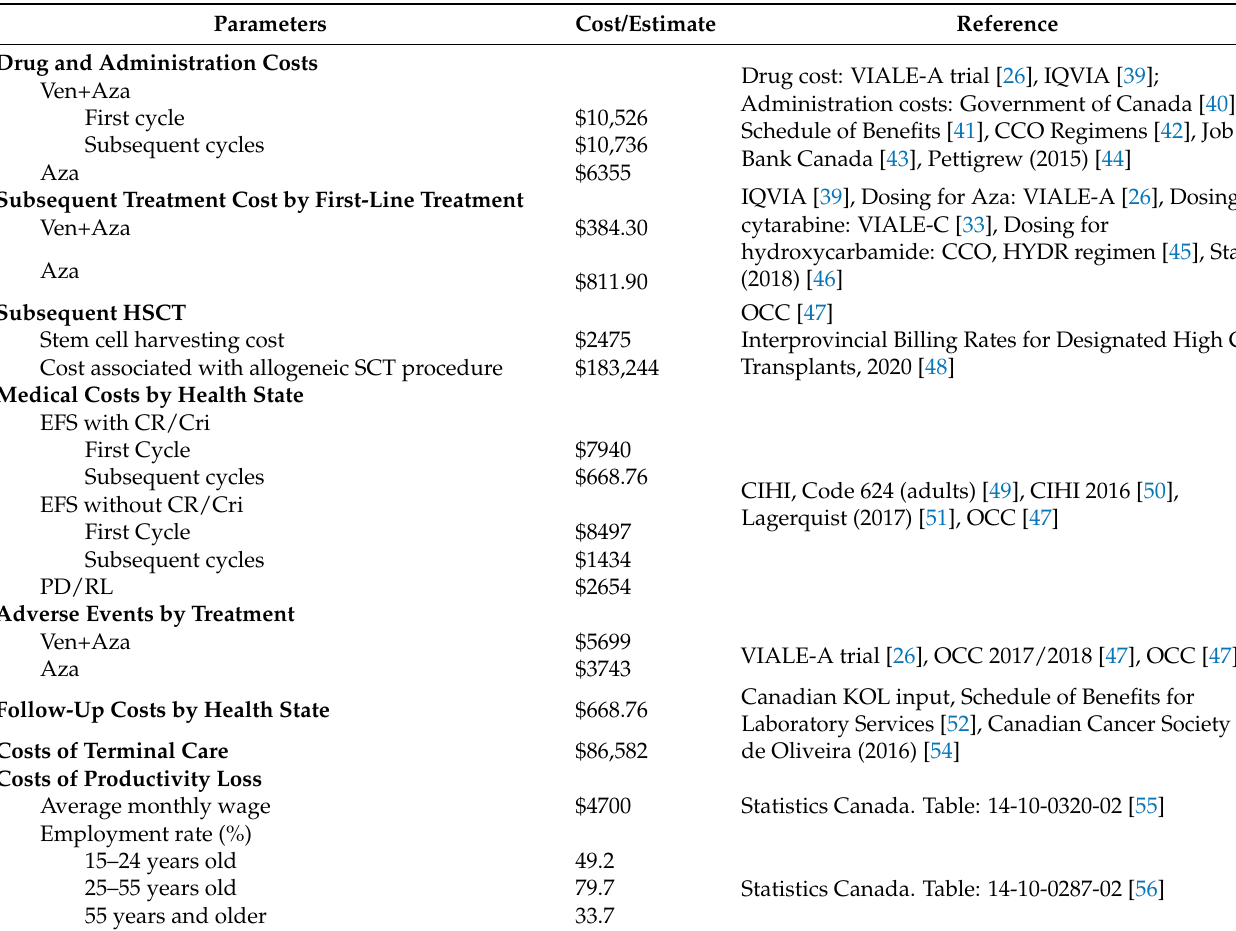
Table 2. Model cost inputs (Canadian